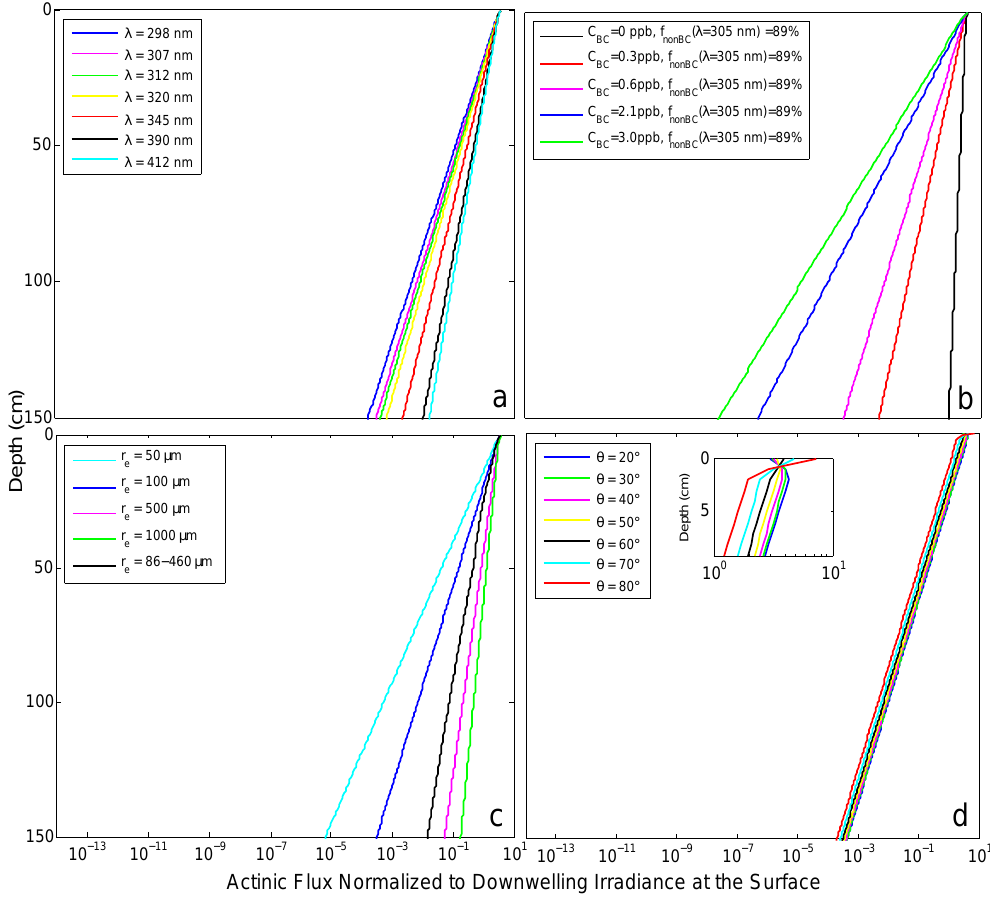
Fig. 3. Dependence of the actinic flux depth profile on wavelength, λ (a) , concentration of black carbon in the snowpack, C BC (b) , ice grain radius, r e (c) , and solar zenith angle, θ (d) . In (c) , the black line is the depth profile of actinic flux using vertical r e profile ranging from 86µm at the snow surface to 460µm at a depth of 500cm. In (d), a zoomed in view of the top 10cm is provided. In (a–d) , ˚A=2.90, f nonBC 305 = 89%, and λ , C BC , r e , and θ were varied around a reference case of θ = 60°, r e = 100µm, λ = 305nm, C BC = 0 . 6ngg − 1